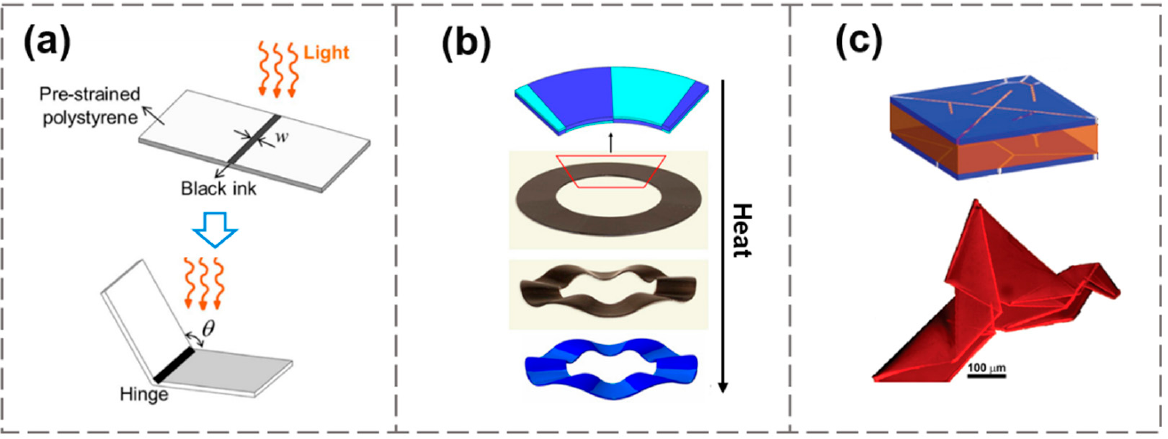
Figure 3. ( a ) Bilayer bending hinge. Reproduced from Ref. [78]; ( b ) Bilayer wrinkling ring. Repro- duced from Ref. [79]; ( c ) Tri-layer origami bird. Reproduced from Ref.